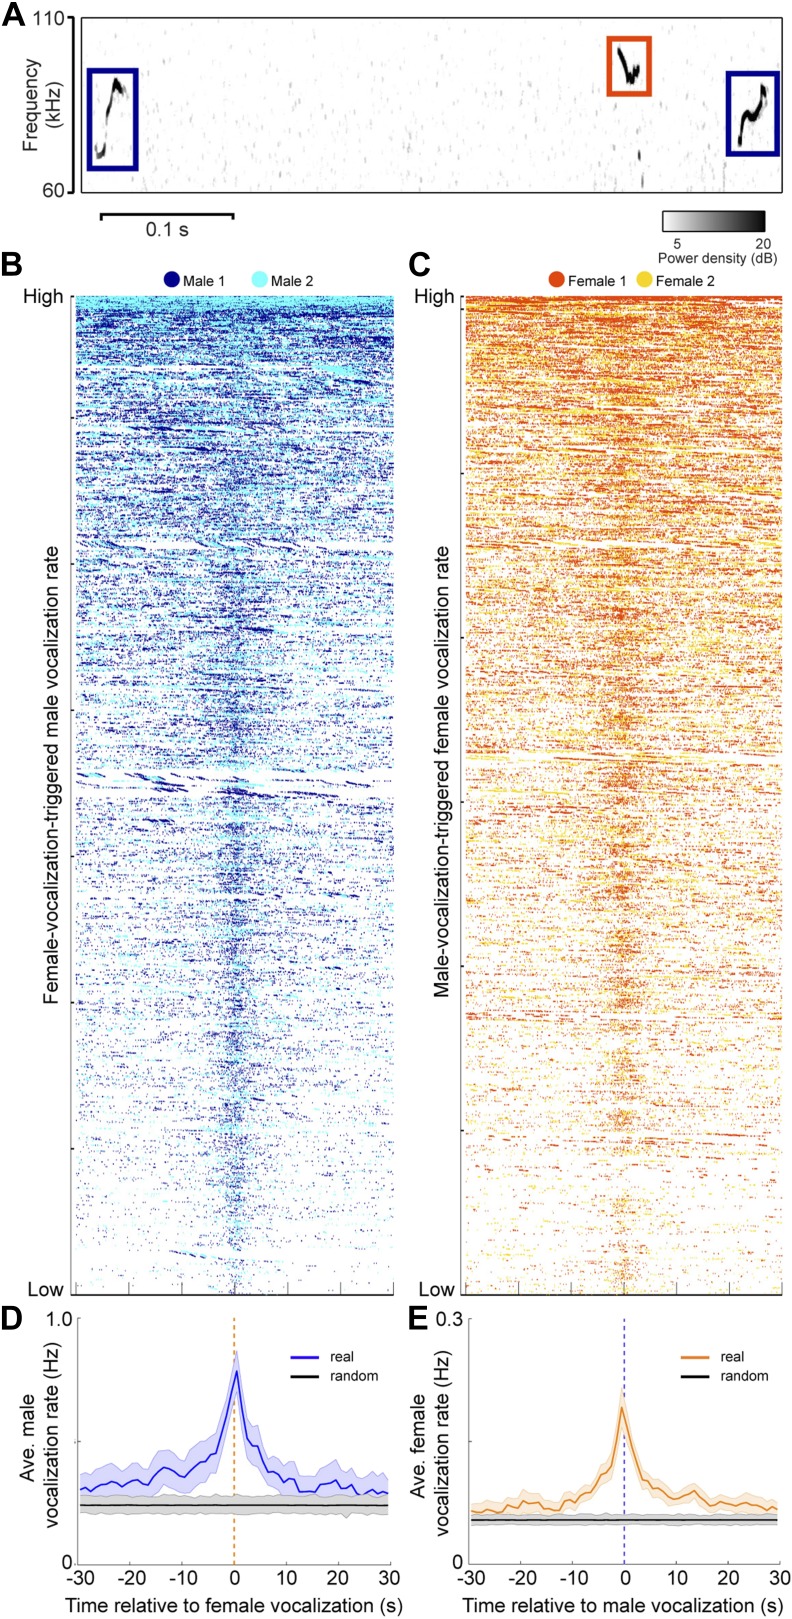
Male and female mice vocalize together.(A) Example spectrogram of male and female USVs. (B) Raster plots of male USVs plotted relative to female vocalizations (each row is associated with a single female vocalization with onset at t = 0 s; female vocalizations = 6832; rows sorted by male vocalization rate). (C) Female USVs plotted relative to male vocalizations (male vocalizations = 30,395; rows sorted by female vocalization rate). (D–E) Plots of female-vocalization-triggered average male USV rate (D) and male-vocalization-triggered average female USV rate (E). Colored lines represent group averages (n = 7) with SEM (shaded patch). Black lines represent group averages (n = 1000) for randomly generated trigger times. Light gray patches show the range of the randomly generated group averages.